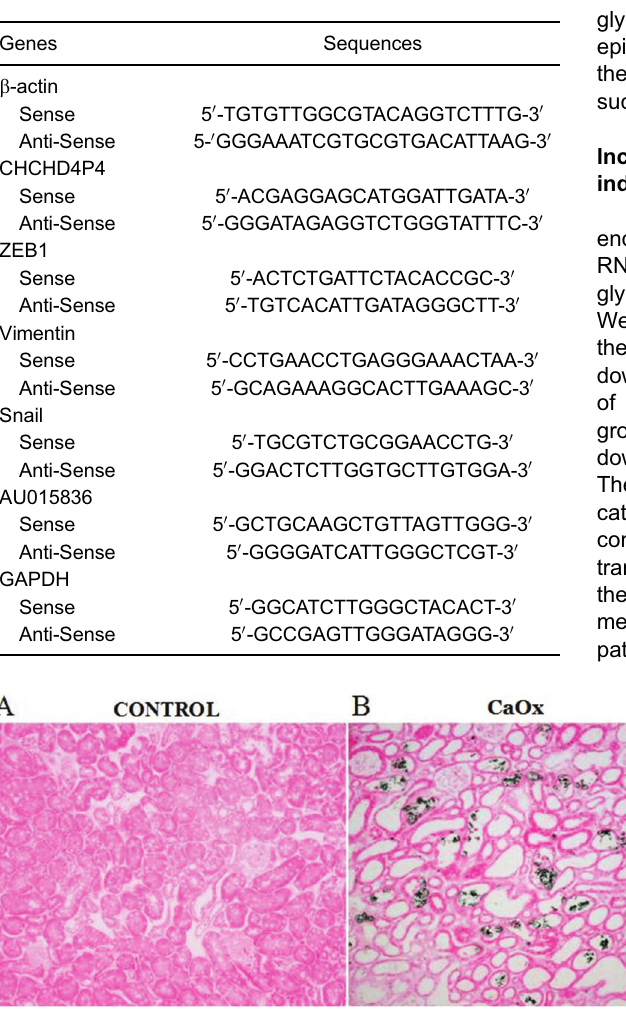
Table 1. Real-time RT-PCR primers.